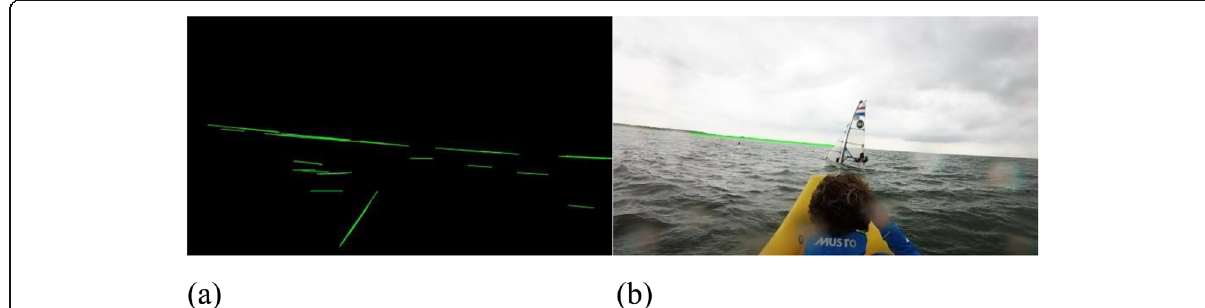
Fig. 3 Output of the PPHT and the line used as the horizon. a : Lines detected after applying the line detection algorithm; b : Example of horizon line obtained from ( a )